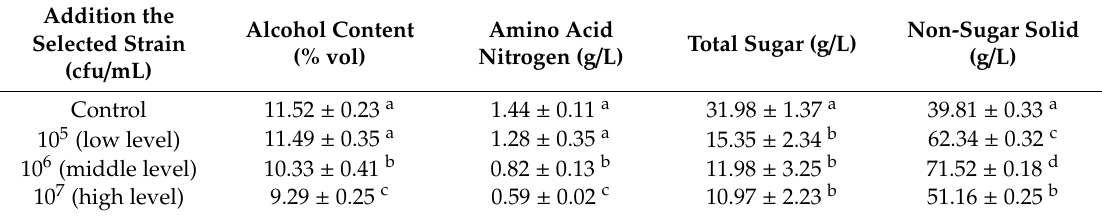
Table 3. The alcohol content, amino acid nitrogen, total sugar and non-sugar solid in the Chinese rice wine after production